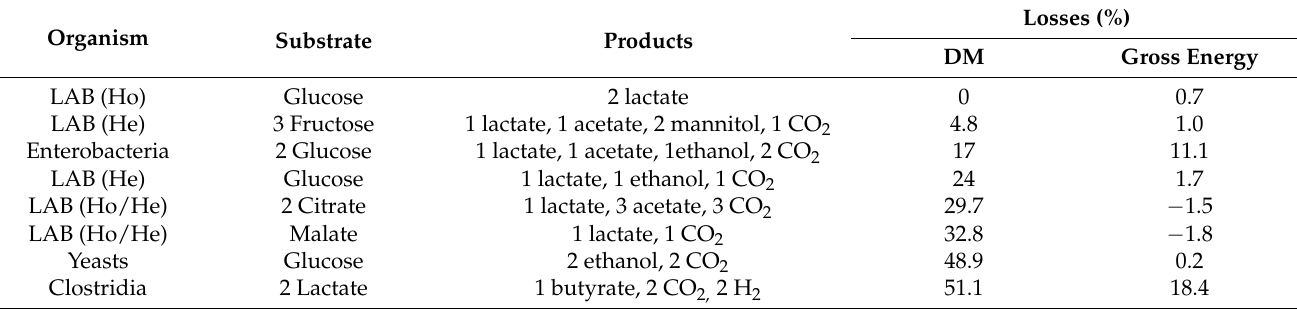
Table 1. Losses of DM and gross energy related to the substrate being fermented by epiphytic microorganism